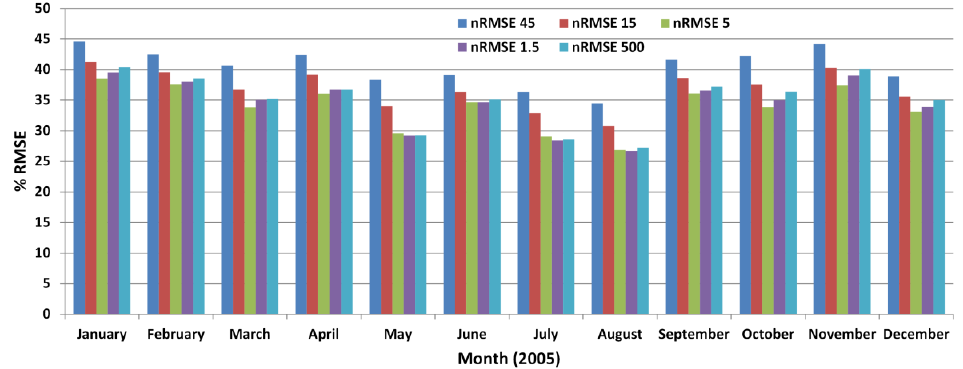
Figure 3. The % normalized RMSE with respect to the average for TAPM horizontal resolutions of 45 km, 15 km, 5 km, 1.5 km, and 500 m for each month of